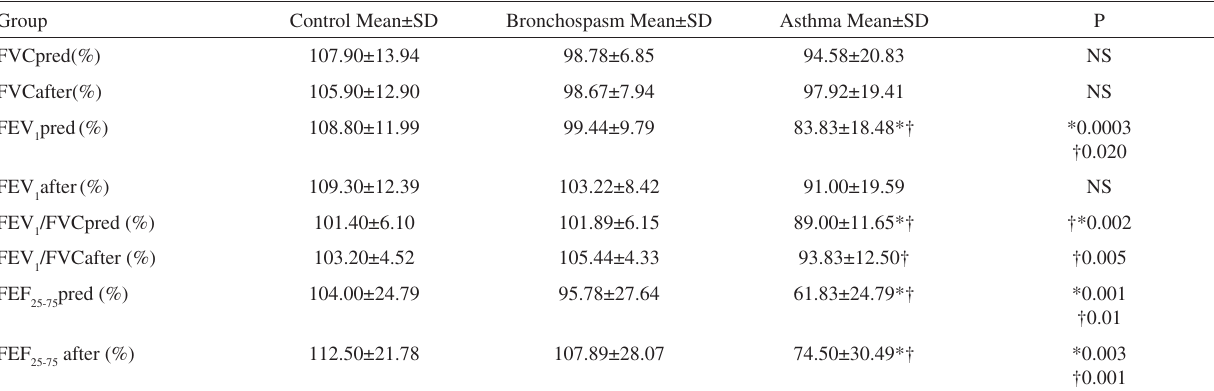
- Forced expiratory volume in 1s; FEV 1